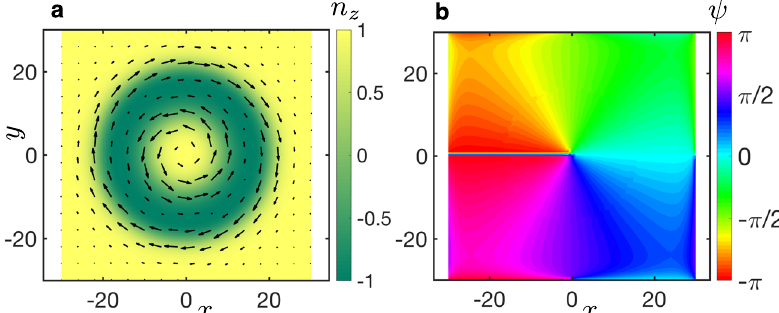
Fig. 6 Coreless vortex in the uniform spiral state. This topological defect consists of a target skyrmion formed by the vector chirality n (panel b ) and a vortex, in which the angle ψ varies by − 2 π along a closed loop around the center of the defect (panel b ). Arrows show in-plane components of n ; n z and ψ are color-coded. The numerical simulation was done for J ⊥ = 1, λ = 0.34, K 1 = 0, K 2 = 0.1, and H = 0.